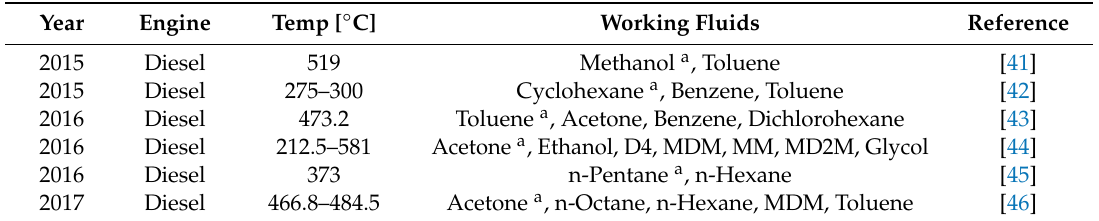
Table 1. Review of organic Rankine cycle (ORC) coupled to Internal Combustion Engine (ICE).